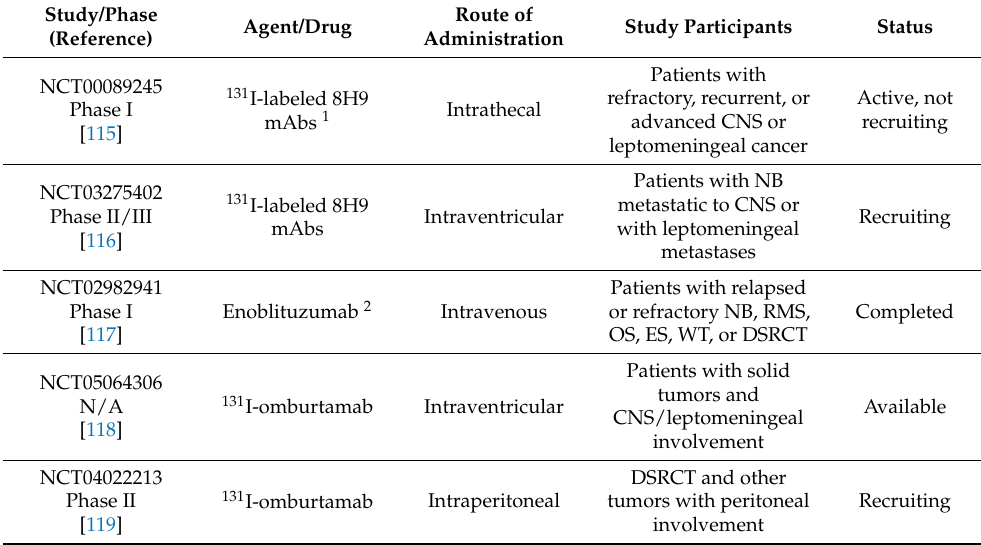
Table 2. B7-H3-targeting mAb-based anti-tumor agents in clinical studies involving PSTs. The table shows the studies on extracranial PSTs as well as the studies involving their metastases in the CNS. Study/Phase (Reference)